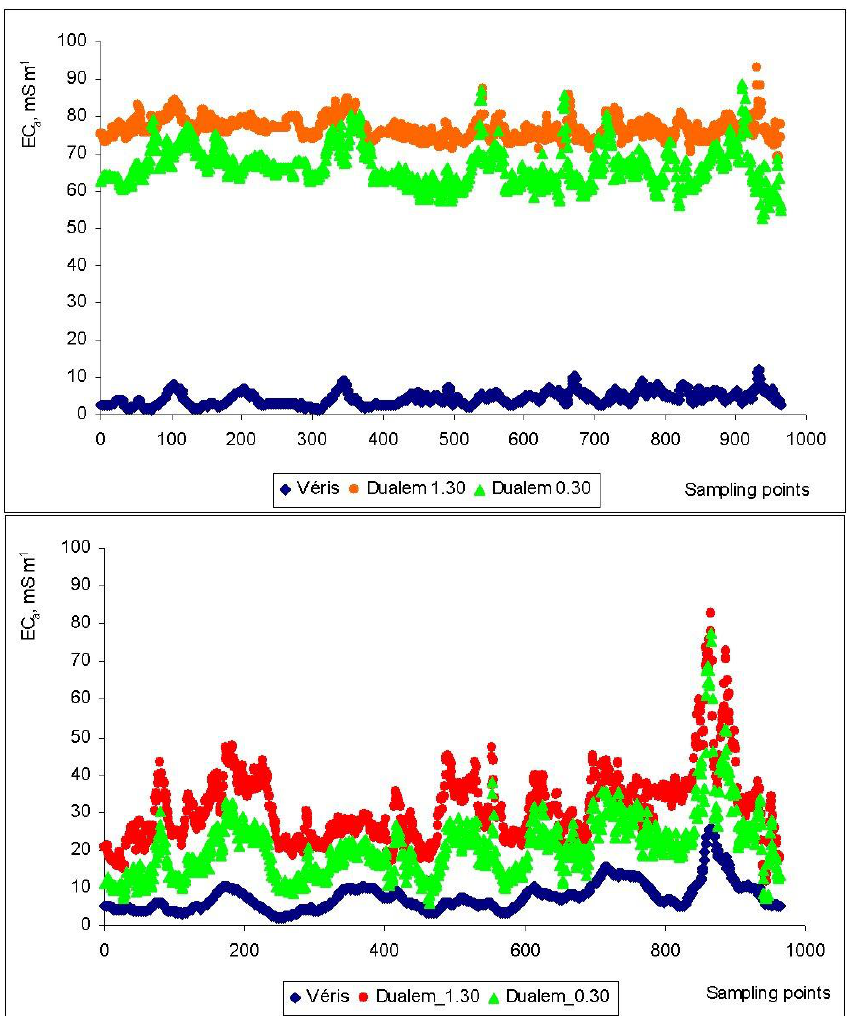
Figure 8. Apparent soil electrical conductivity measured by the Veris and DUALEM sensors in the experimental field in February 2012 ( above ) and February 2013 ( bottom ).